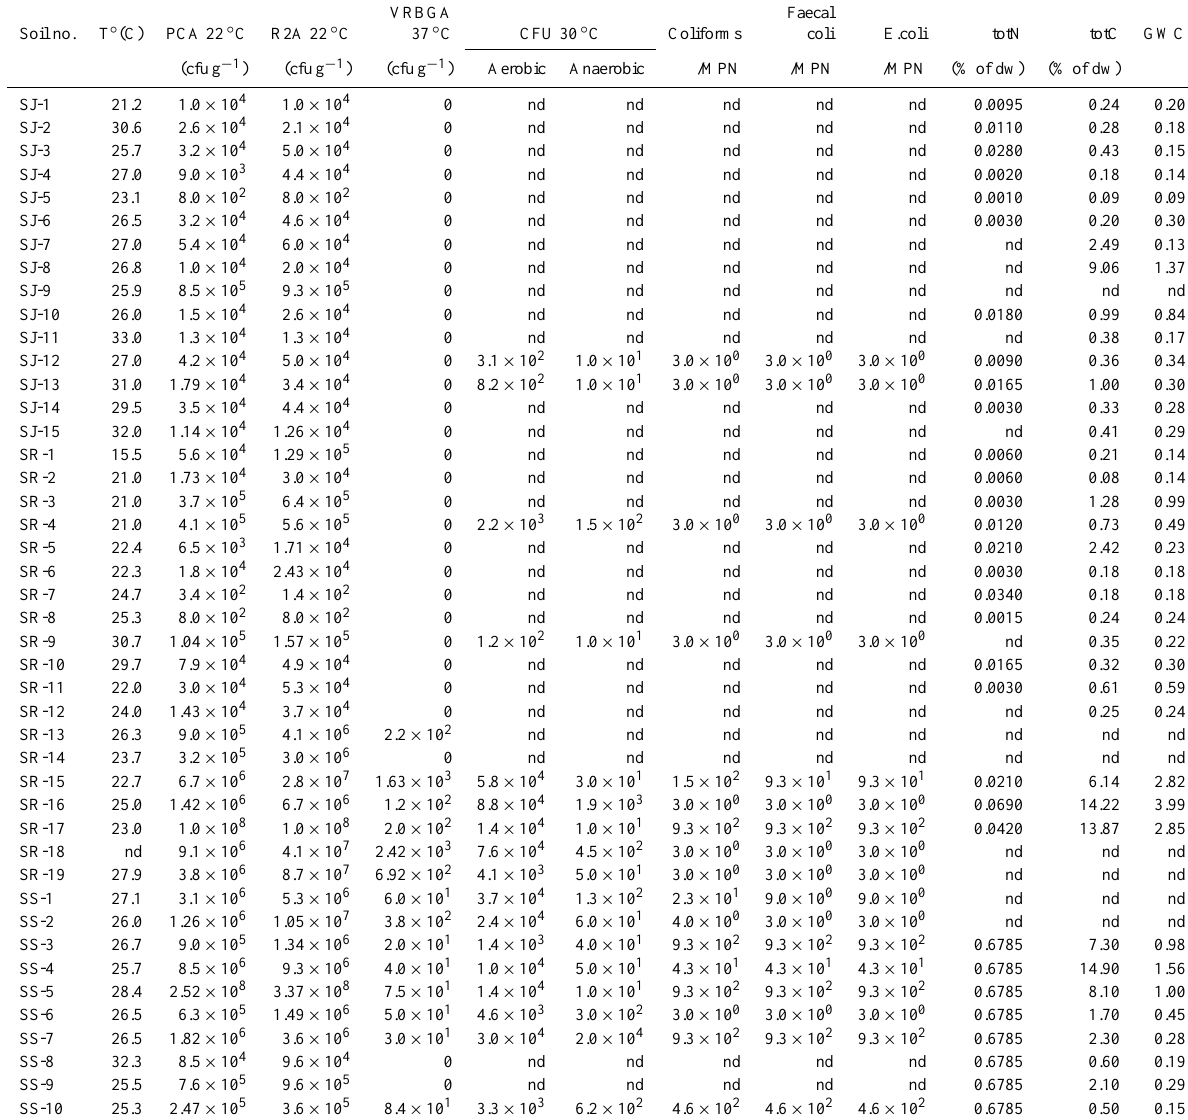
Table 1. Viable count of total coliforms, faecal coliforms, Escherichia coli , and aerobic and anaerobic bacteria growing at 30 ◦ C and detection of pathogens on different media (PCA, R2A,